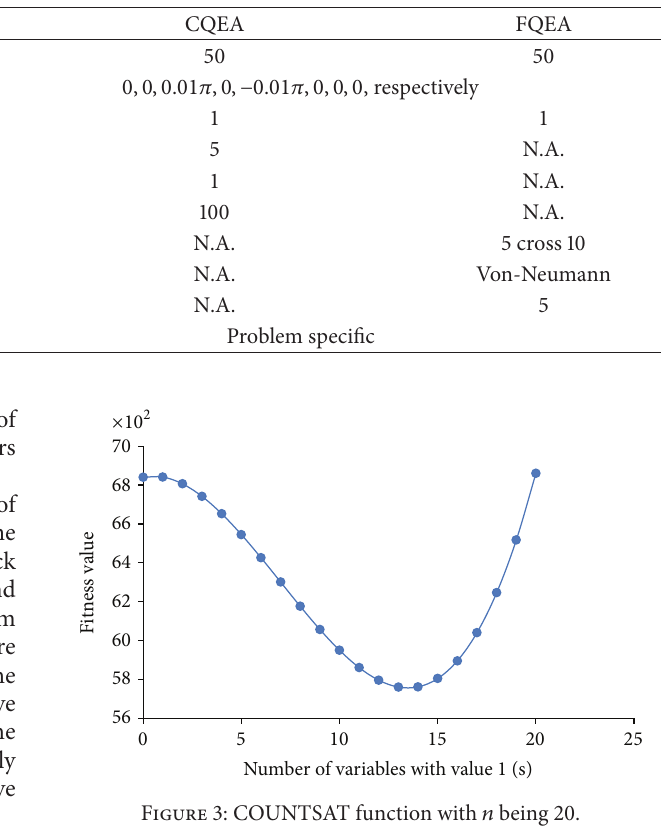
Table 1: Parameter setting for PQEA, CQEA, and FQEA.